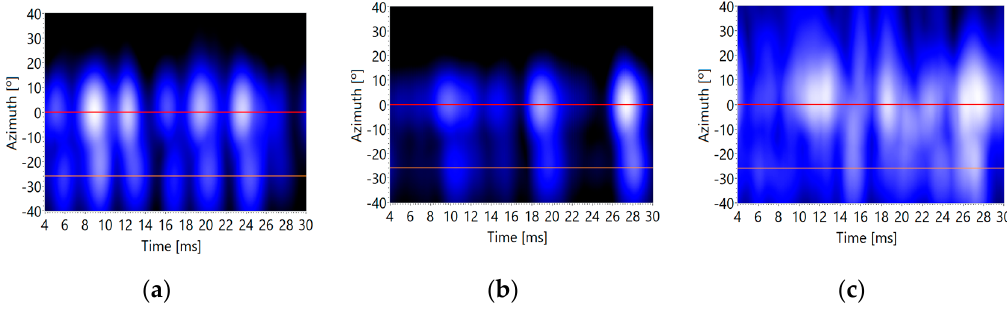
Figure 13. Acoustic image section (azimuth/time) versus background noise levels: ( a ) minimum, ( b ) medium and ( c ) maximum.